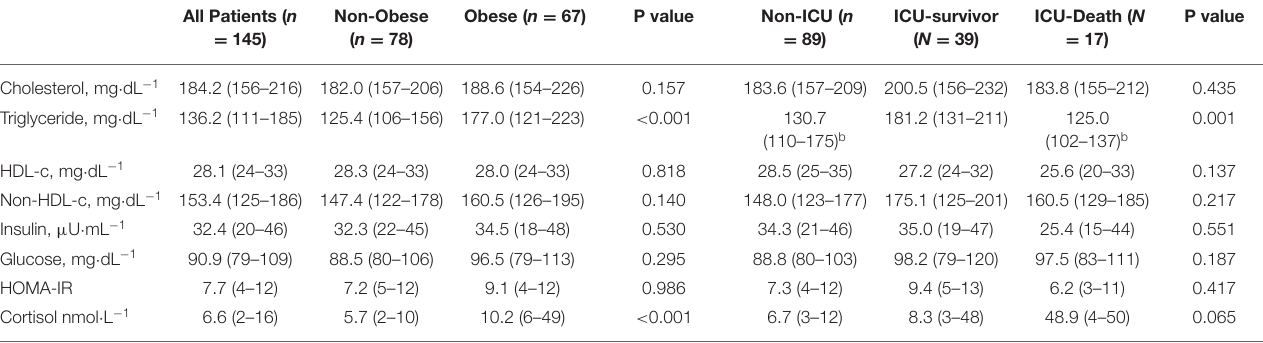
TABLE 2 | Biochemical and metabolic profiles of patients with COVID-19. All Patients ( n =